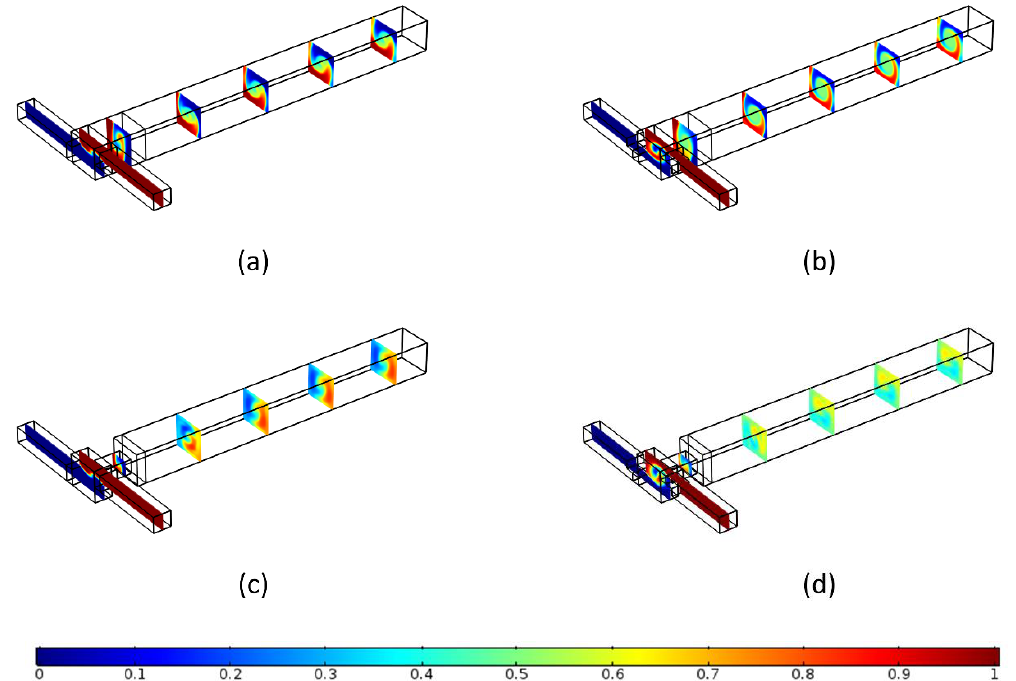
Figure 6. Streamlines and concentration distribution at each section in different micromixer at Re = 50